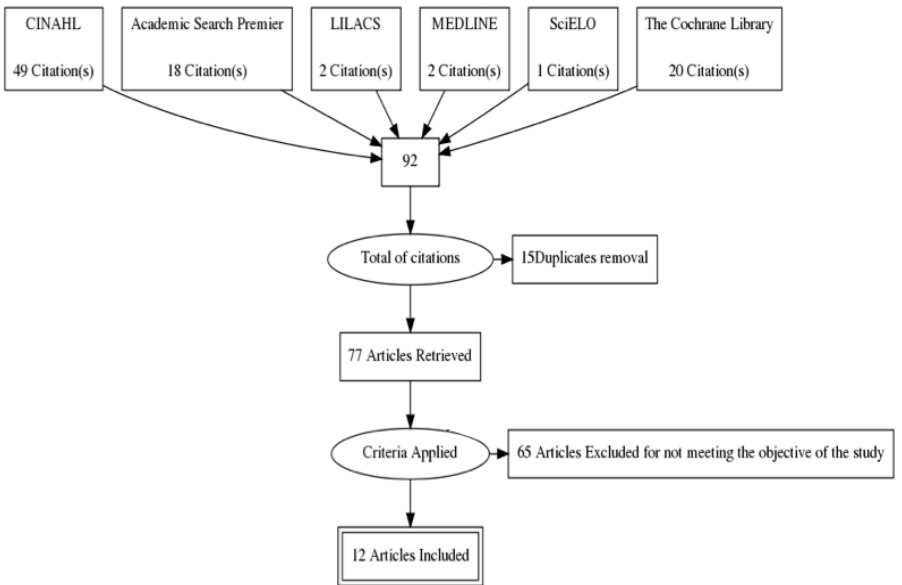
Figure 1. Study selection process.